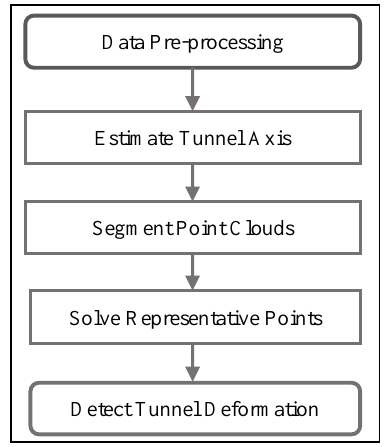
Figure 1. Workflow of the proposed